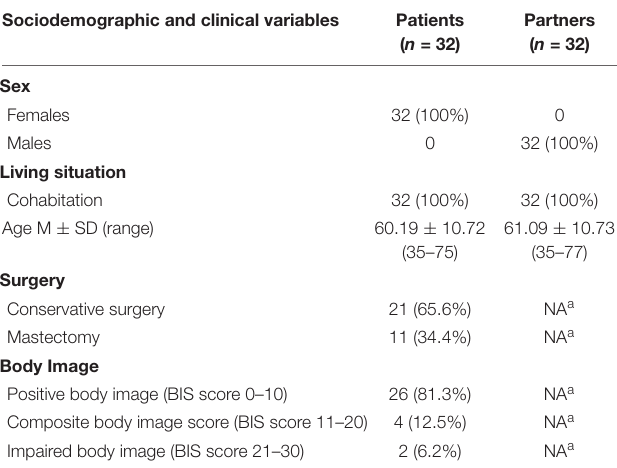
TABLE 1 | Participants’ demographics and clinical characteristics. Sociodemographic and clinical